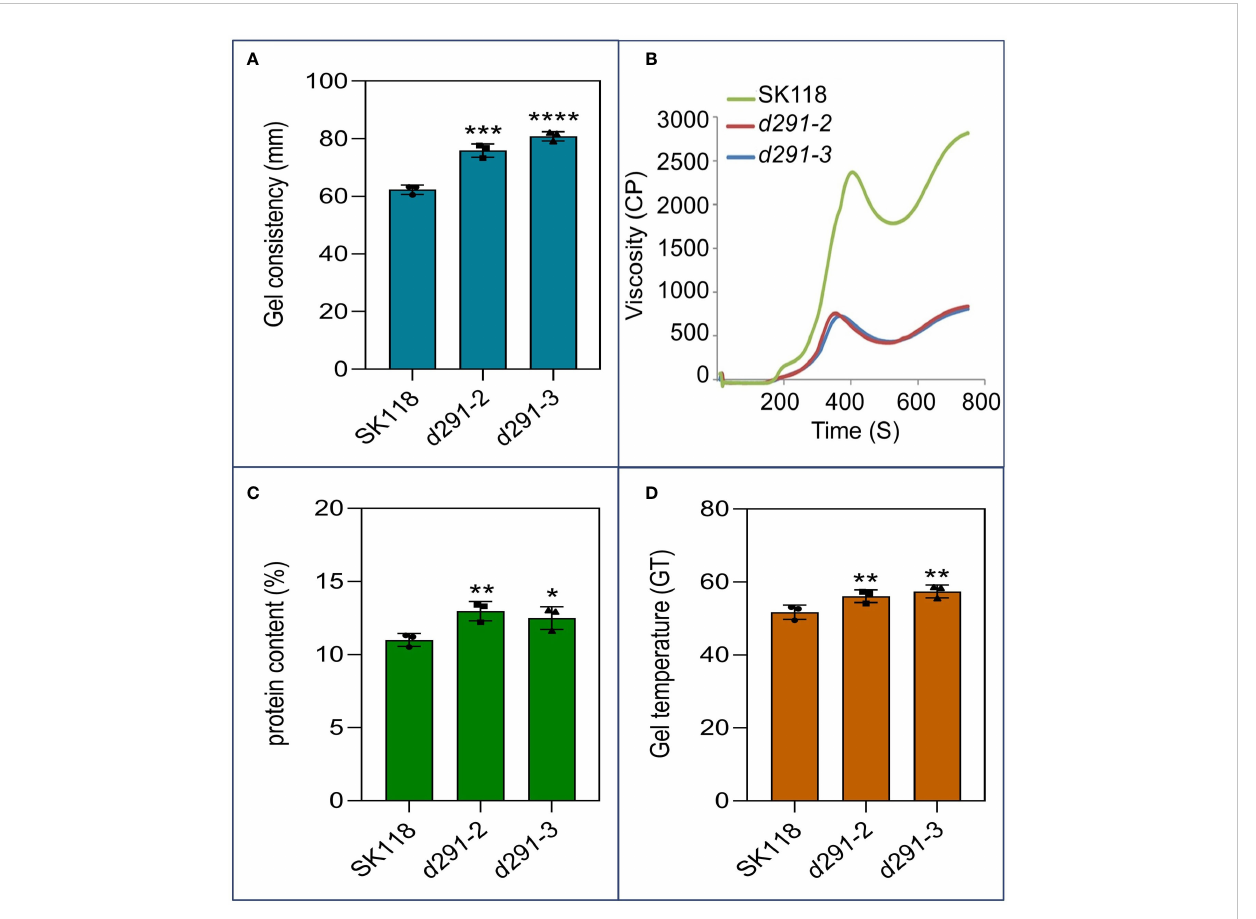
FIGURE 4 Improvement of ECQ and taste value of fl o2 transgenic rice. (A) Gel consistency (mm). (B) RVA spectra of rice fl ours. (C) Total protein content of the rice fl ours (%). (D) Gelatinization temperature (GT) of rice fl ours from SK118, d291-2 and d291-3 . Data are given as the mean ± S.D. (n ≥ 3). Student ’ s t test: *P < 0.05; **P < 0.01; ***P < 0.001; ****P <